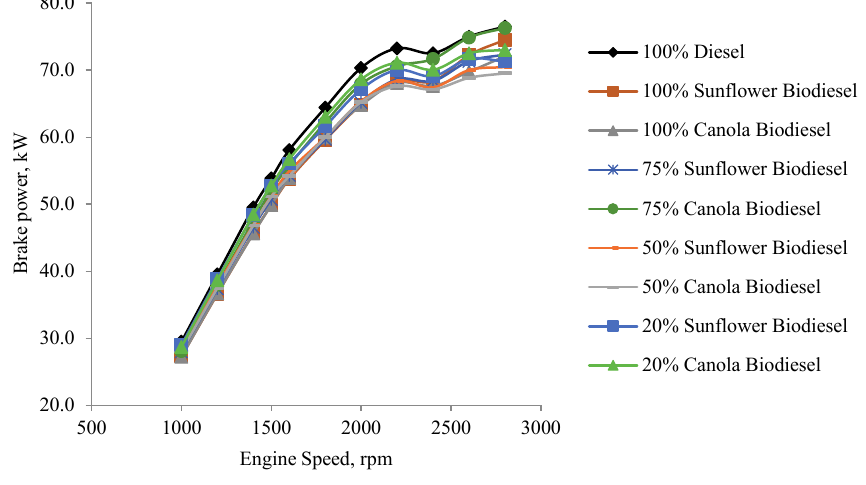
Fig. 7. Power performance against engine